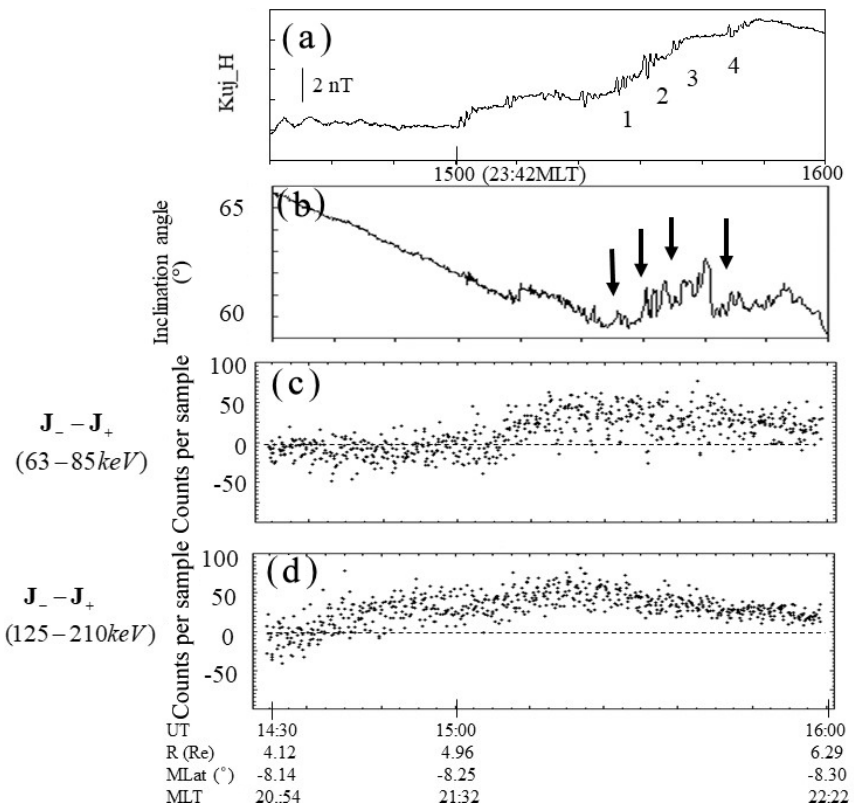
Figure 4. (a) A multiple-Pi2 event (labeled 1, 2, 3 and 4 in the figure) with positive bays observed at a low-latitude station (KUJ) at L = 1 . 2 in the midnight sector (23:42MLT at 15:00UT). The figure, showing data from 14:30 to 16:00UT 31 August 1986, was reproduced from Saka et al. (2002). (b) The inclination angle of field lines in dipole coordinates along the satellite trajectories measured by AMPTE CCE spacecraft. (cid:16) (cid:17) (cid:112) H/ V 2 + D 2 Inclination angle ( θ ) was defined as θ = Tan − 1 . H is positive northward parallel to the dipole axis, V is radial outward, and D is dipole east. Vertical arrows denote dipolarization onset corresponding to the multiple Pi2s: 1, 2, 3 and 4 in (a) . (c) Difference of duskward flux (counts per sample) ( J − ) and dawnward flux ( J + ) for 63–85keV ion channel measured by AMPTE CCE spacecraft. (d) Same as for (c) but for the 125–210keV ion channel. Radial distance ( R ) in R e , MLaT in degrees, and MLT at 14:30, 15:00 and 16:00UT along satellite trajectory are shown in the